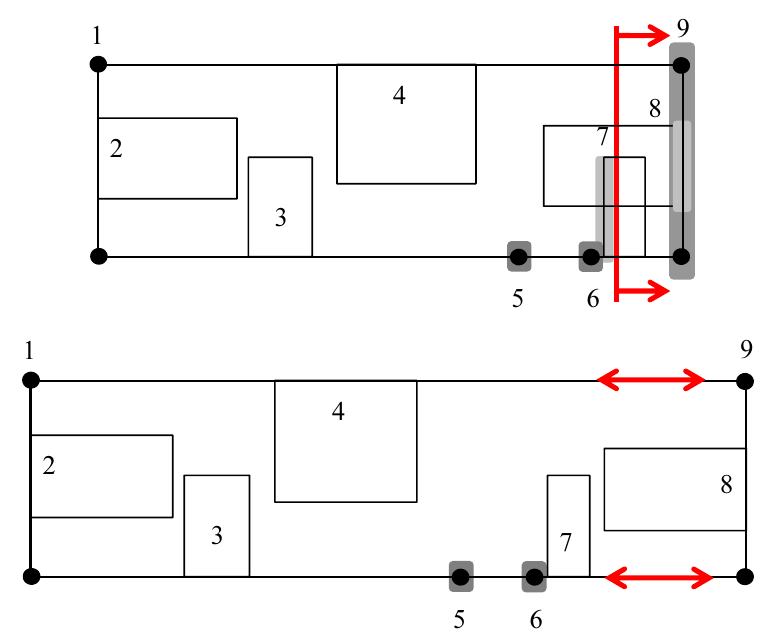
Figure 17. The step of the plane sweep algorithm that resolves overlaps for Label 7.